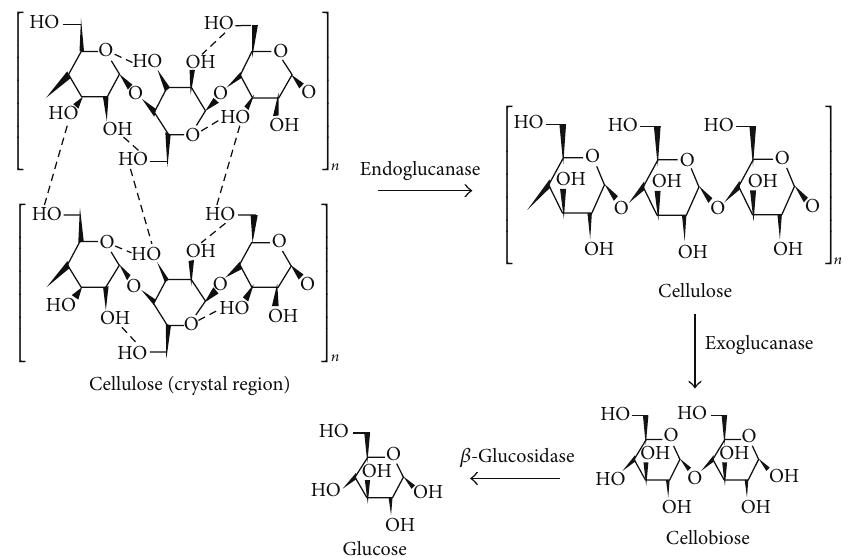
Figure 1: Enzymatic degradation of cellulose. Adopted from Karmakar and Ray [3].